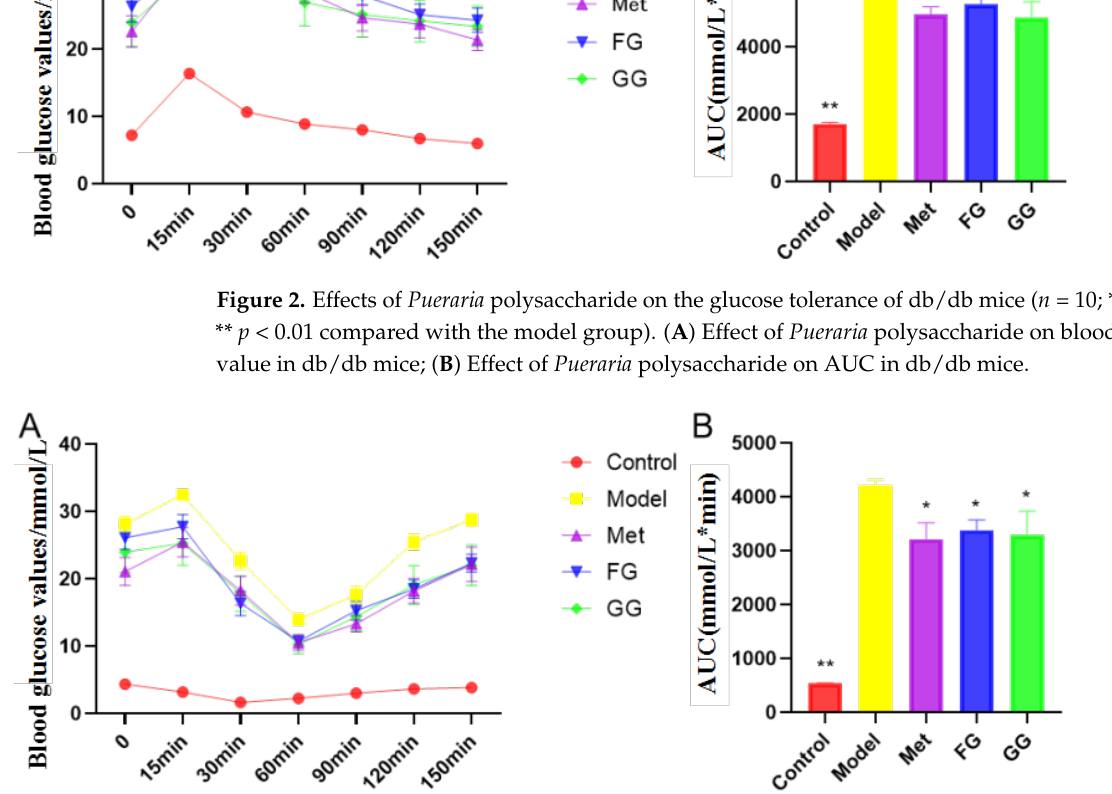
Figure 3. Effect of Pueraria polysaccharide on the insulin tolerance of db/db mice ( n = 10; * p < 0.05; ** p < 0.01 compared with the model group). ( A ) Effect of Pueraria polysaccharide on blood glucose value in db/db mice; ( B ) Effect of Pueraria polysaccharide on AUC in db/db mice.